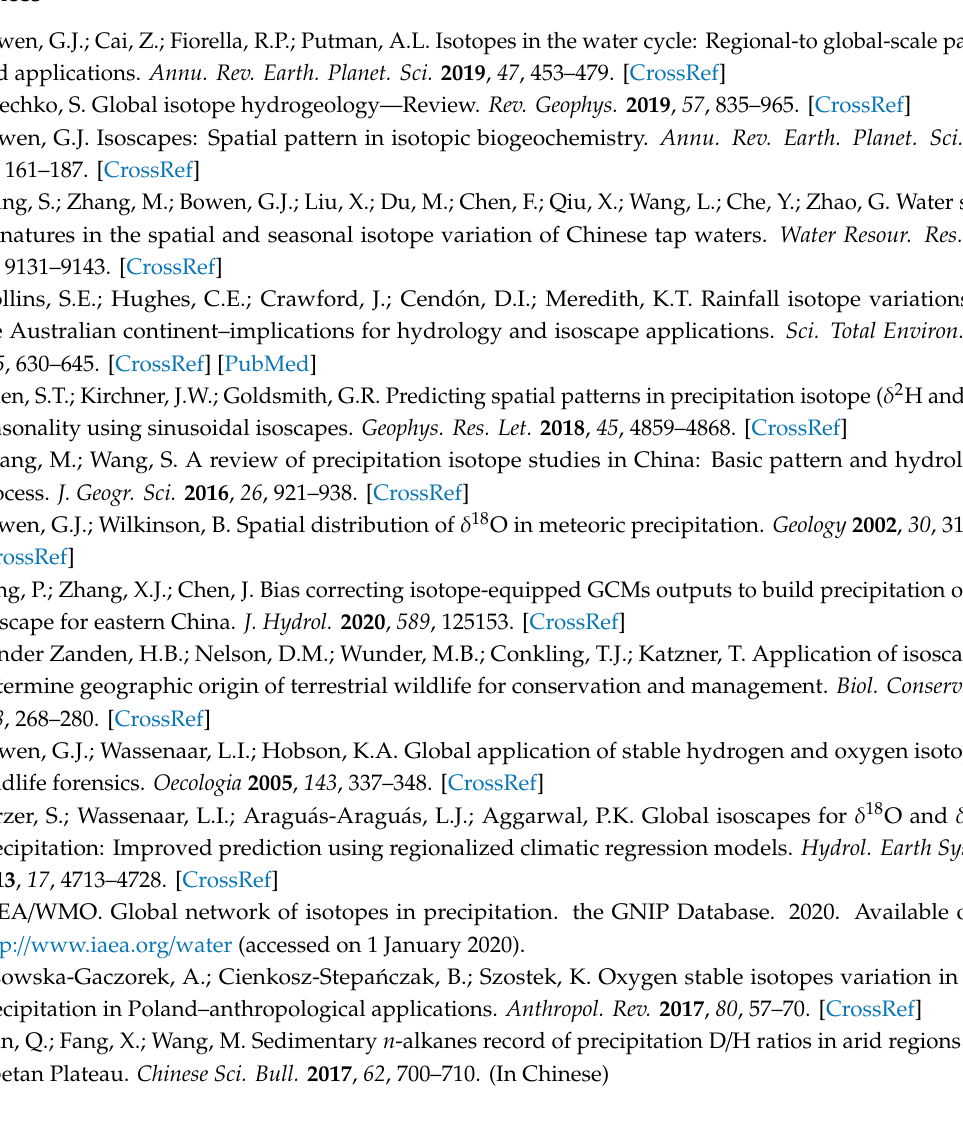
Table S1: Regression factors applied for each month over the QTP. Table S2: The R 2 values of OIPC and RCWIP for each station over the